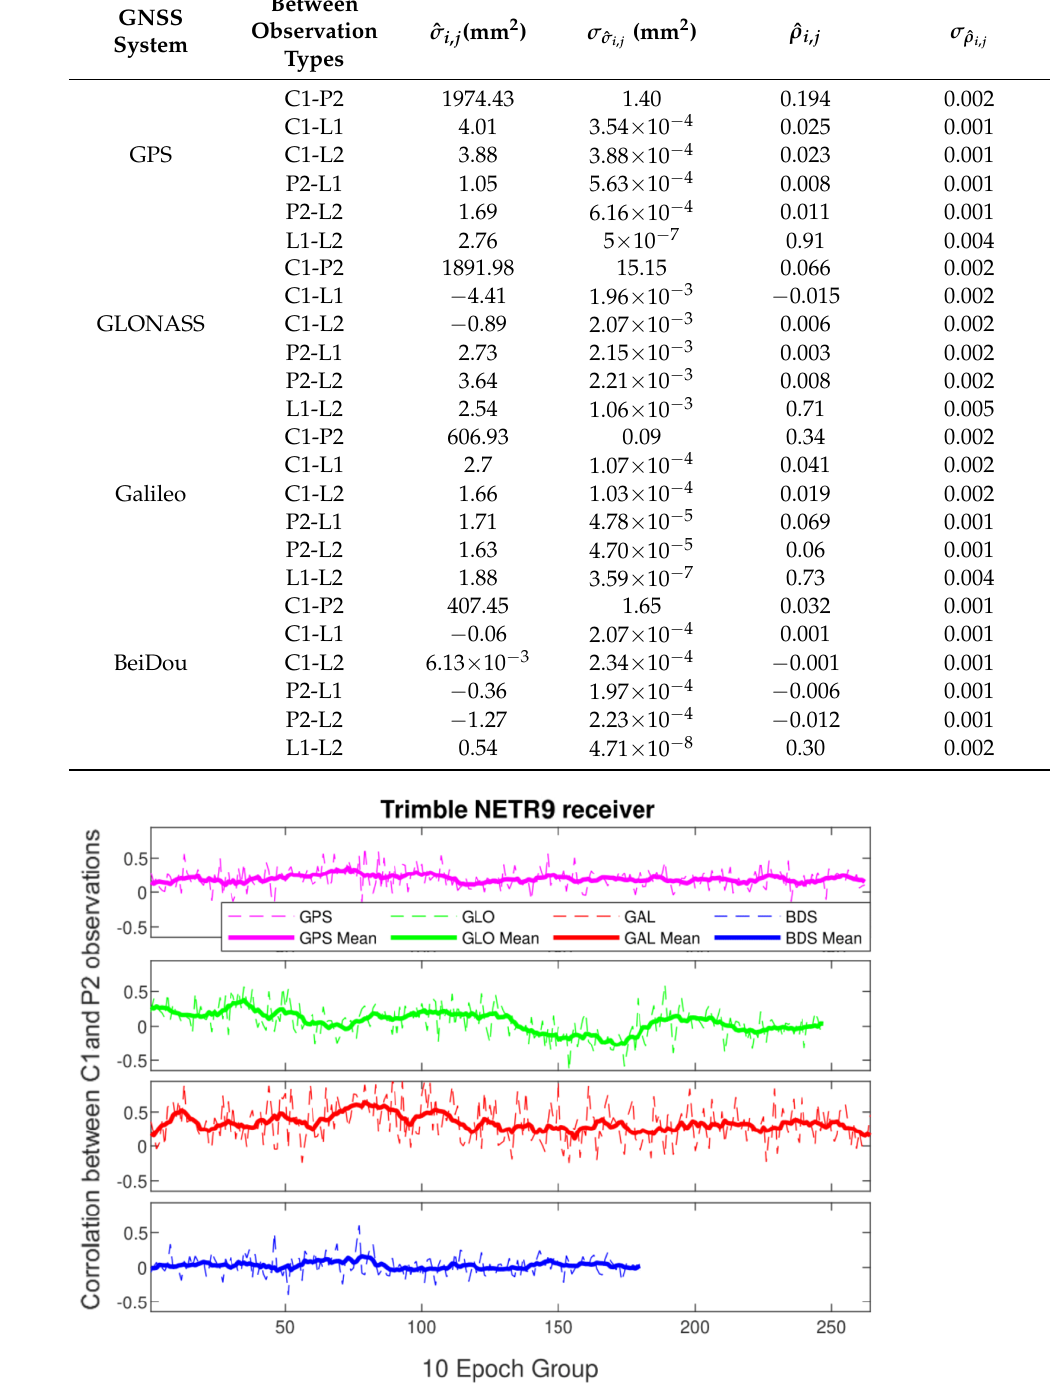
Figure 6. Estimated correlation coefficients between the C1 and P2 observations (dashed line) with their average values in 10 epoch group windows (bold line) over a zero